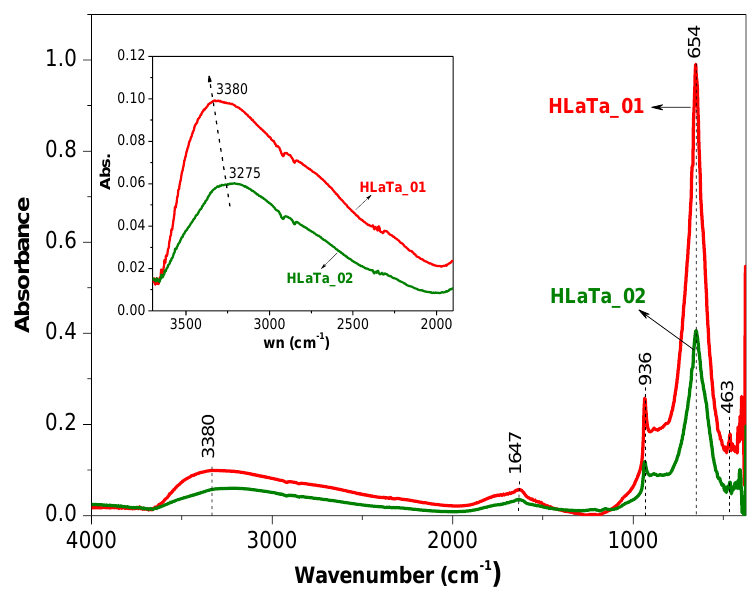
Figure 8. FTIR spectra of HLaTa_01(02) proton-exchanged layered perovskites. The insert represents the magnified region corresponding to hydroxyl group. Catalysts 2020 , 10 , x FOR PEER REVIEW